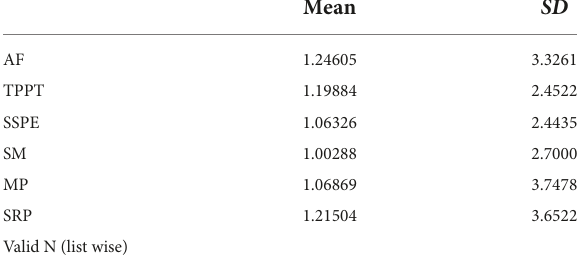
TABLE 3 Independent t